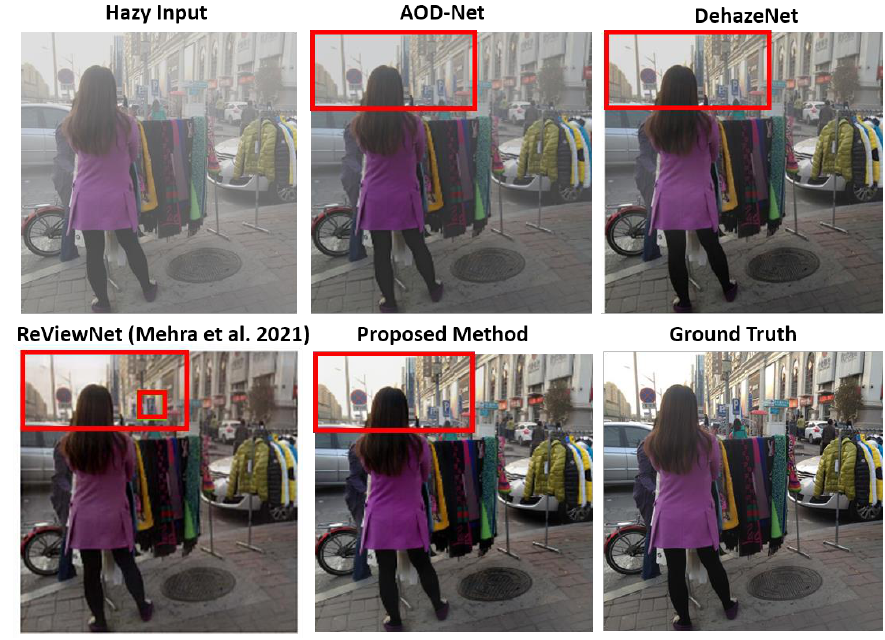
Figure 9. Comparison of dehazing results of traffic signs, cars, and sky region [28].